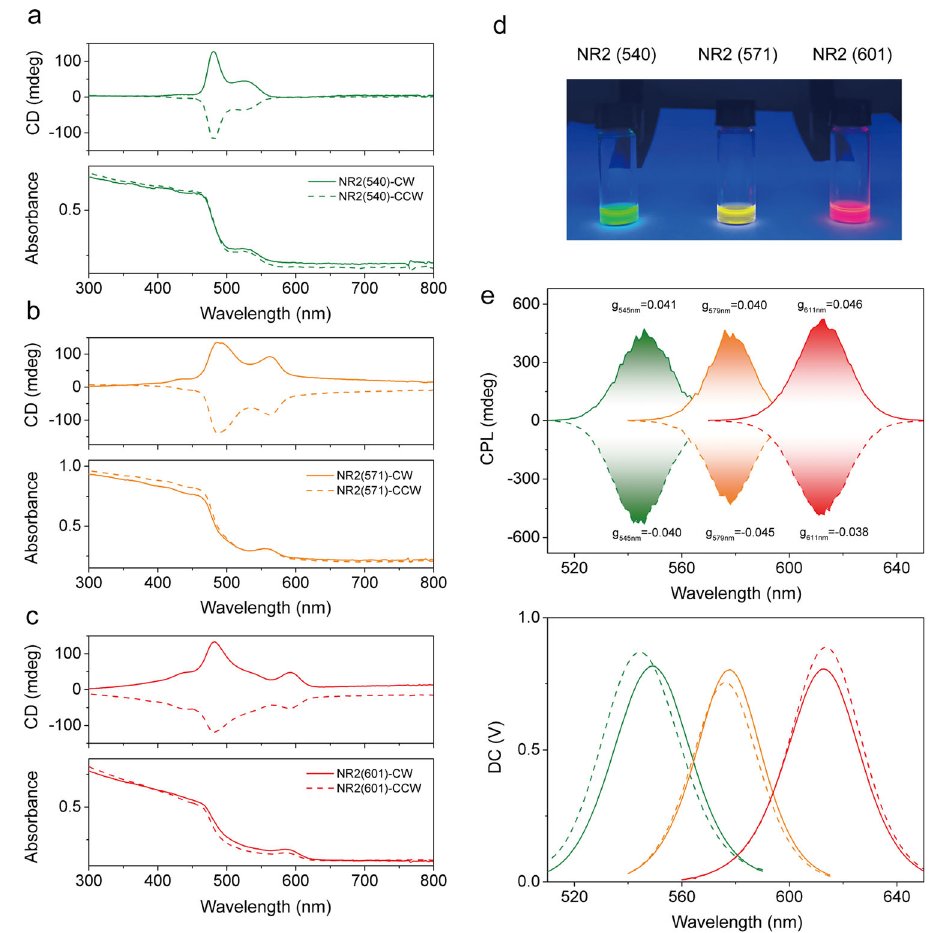
Fig. 3 | Chiroptical properties of CdSe-CdS NRs with different emissions. a CD spectra and UV − Vis absorption spectra of NR2(540) assemblies. b CD spectra and UV − Vis absorption spectra of NR2(571) assemblies. c CD spectra and UV − Vis